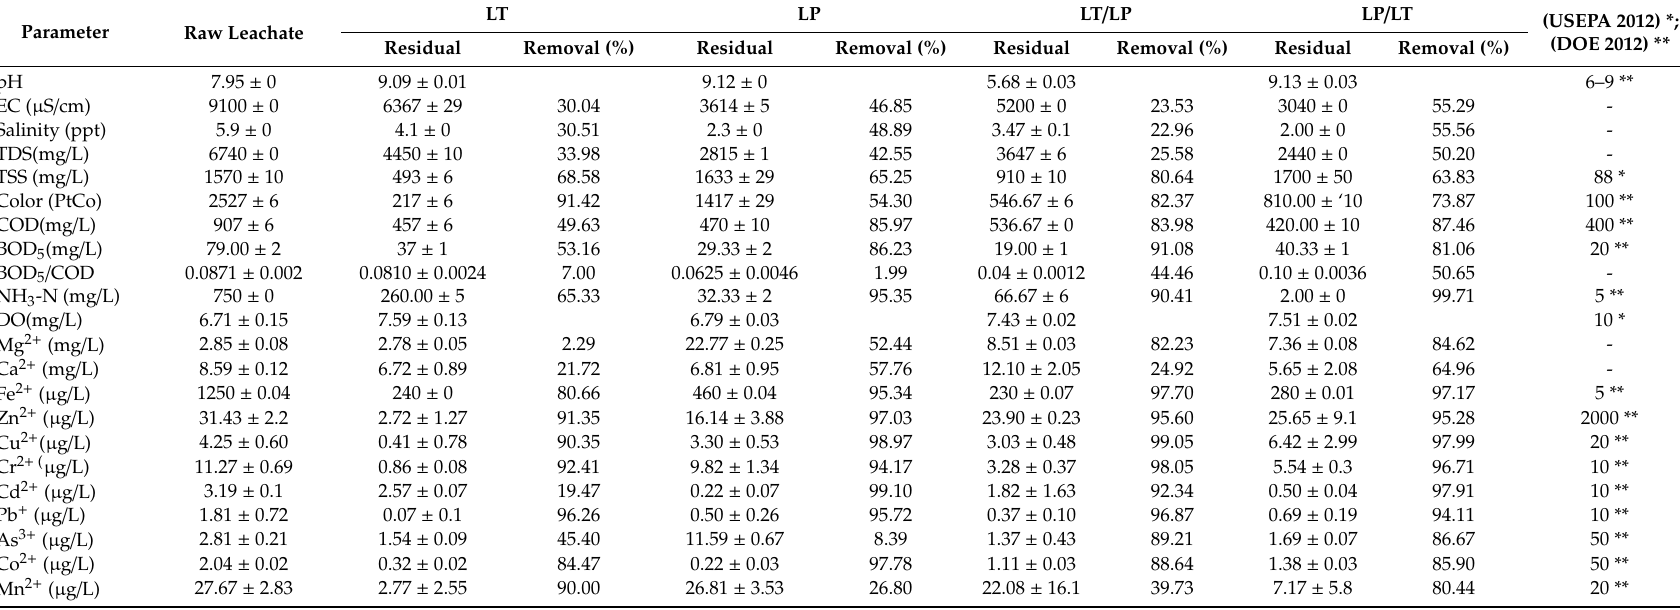
Table 2. Comparison of the four treatment applications in terms of the physicochemical parameters and heavy metals: combined leachate / palm oil mill e ffl uent (POME) (LP), leachate / tannin (LT), pre-(leachate / tannin)–post-(leachate / POME) (LT / LP), and pre-(leachate / tannin)–post-(leachate / POM) (LP / LT). Parameter Raw Leachate